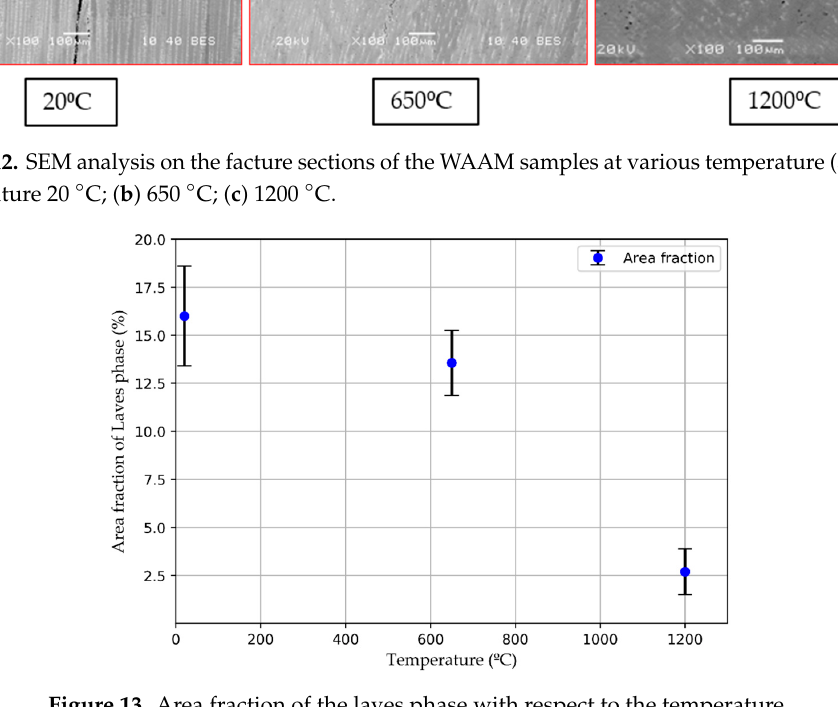
Figure 13. Area fraction of the laves phase with respect to the temperature.